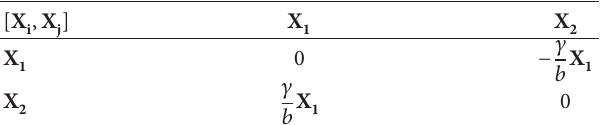
Table 4: Commutator table of the tumor equation. Table 5: Commutator table of the tumor equation.